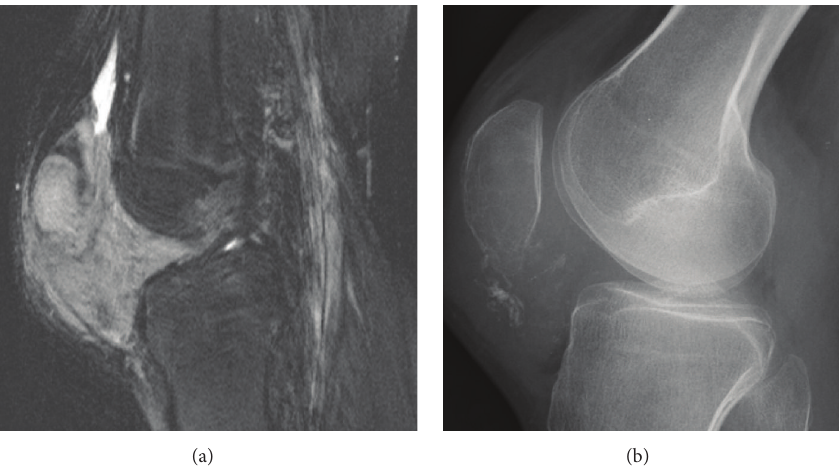
Figure 2: 17-year-old boy with a large sarcoma in Hoffa’s fat pad (case #S4). (a) Sagittal fat-saturated T2-weighted MR image shows the tumor growing extra-articularly and invading the patella. (b) Lateral radiograph shows intratumoral calcifications.